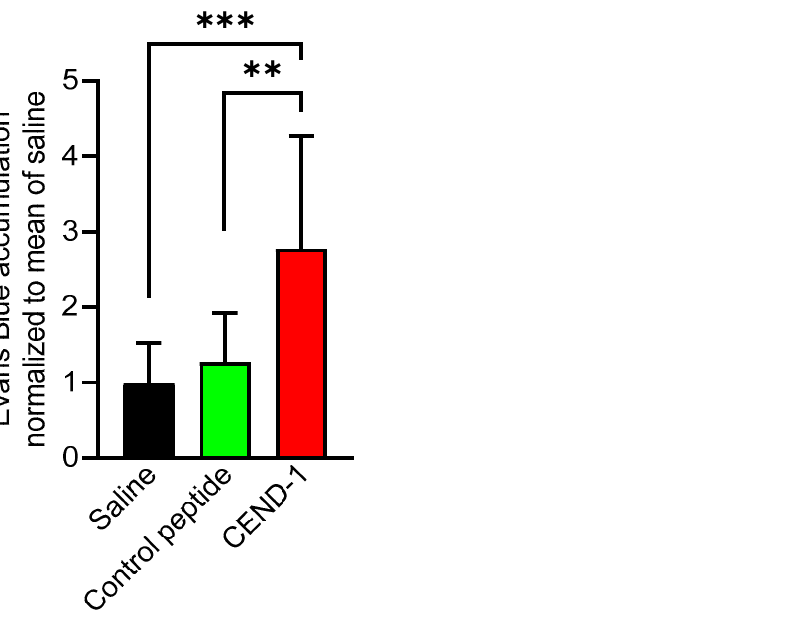
Figure 4. CEND-1 increased the tumour levels of Evans blue in HCCs, when the dye was injected 24 h after injection of the peptide. TGF α /c- myc mice bearing MRI-verified liver tumours were intravenously injected with 4 µ mol/kg of CEND-1 or control peptide (dissolved in PBS), or PBS alone. Then, 24 h later 33 mg/kg bodyweight of Evans blue was i.v. injected into the mice. Evans blue accumulation in the tumours of the mice was quantified. Bars represent mean ± SD; ** p = 0.01; *** p < 0.001 (one-way ANOVA with Tukey’s multiple comparisons test); n = 11 tumours from four